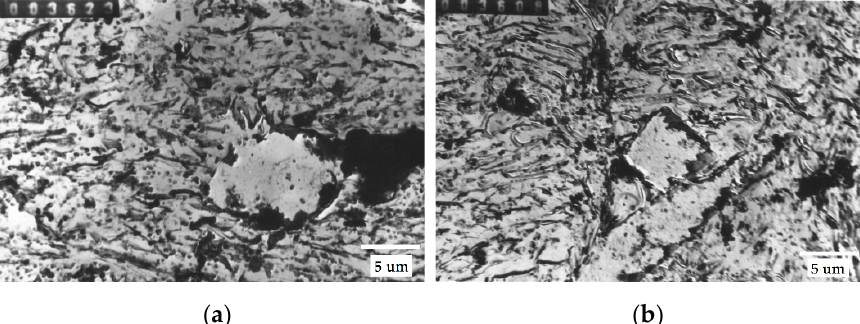
Table 5. Characteristics of non-metallic inclusions. Figure 1. Samples of non-metallic inclusion in research steel: ( a ) highly dispersive Al 2 O 3 particles and multiphase inclusions (SiO 2 ·CaO) deformed during plastic working [50], ( b ) highly dispersive Al 2 O 3 particles with the form of irregularly shaped polyhedra, Cr 2 O 3 inclusions of a parallelepiped structure and SiO 2 inclusions deformed during plastic working.